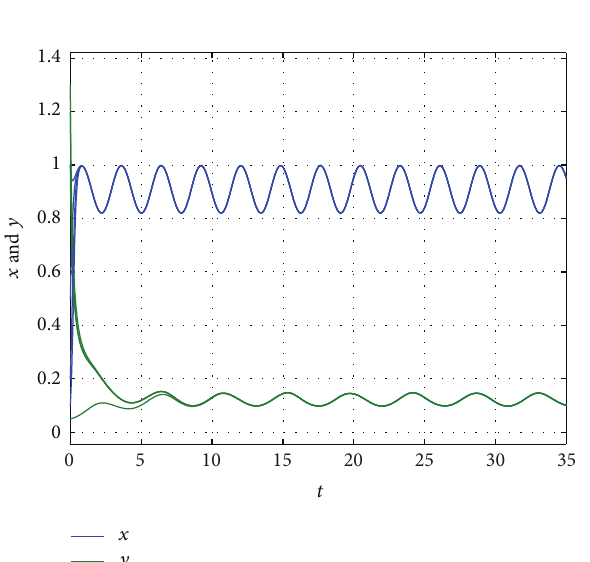
Figure 1: Dynamic behavior of the system (64) with the initial condition (𝑥(0),𝑦(0)) = (0.5, 1) 𝑇 , (1,1.2) 𝑇 , (0, 2,0.05) 𝑇 , and (0.1, 1.3) 𝑇 ,